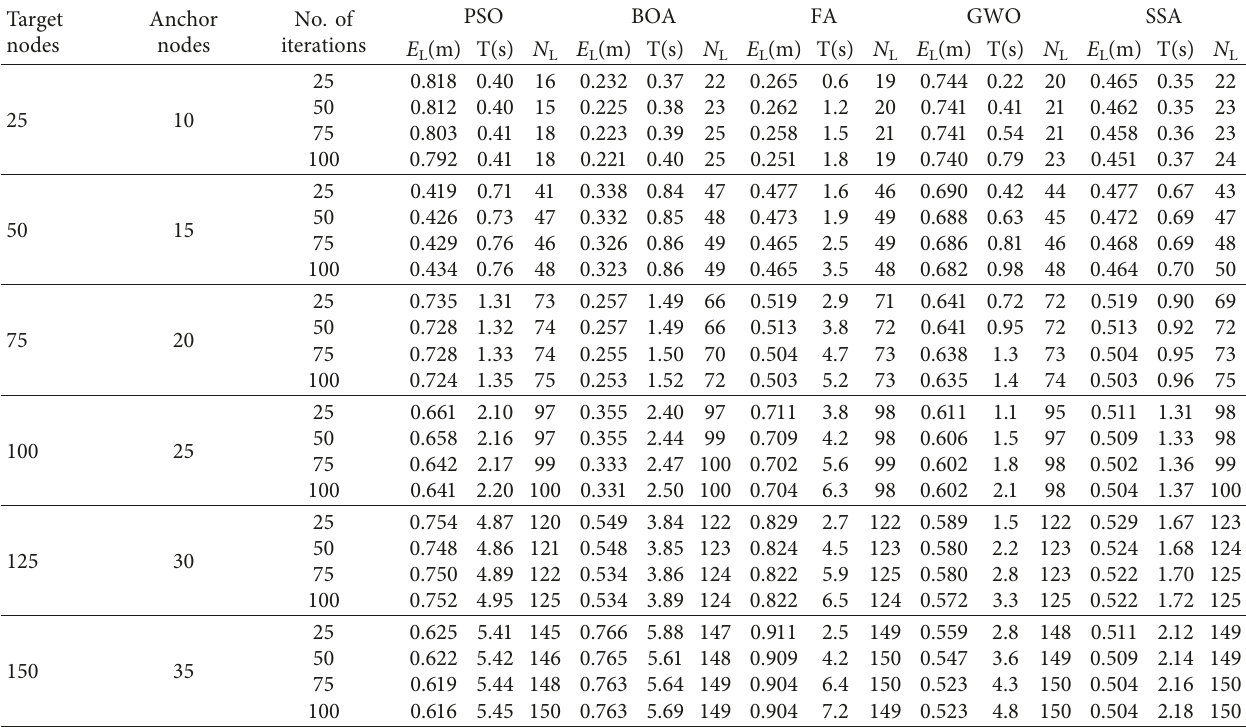
Table 2: Performance metrics of different localization algorithms.